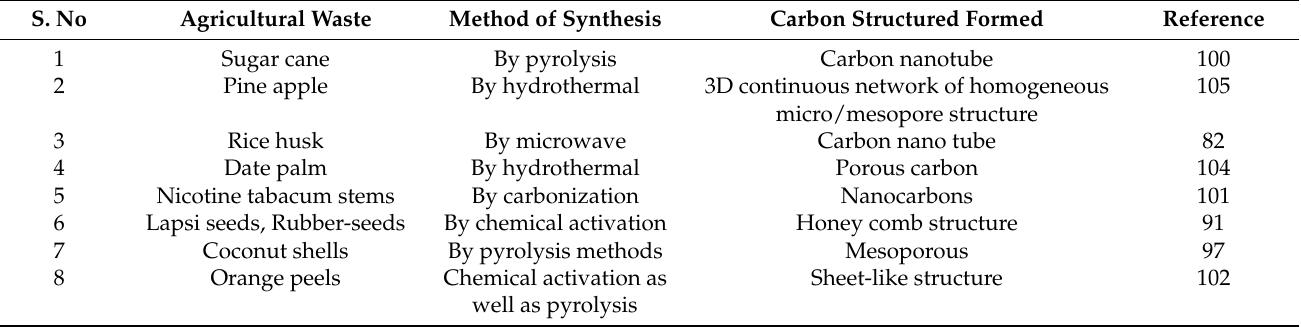
Table 1. Detailed investigation of the agricultural waste, method of synthesis, and its carbon struc- tured